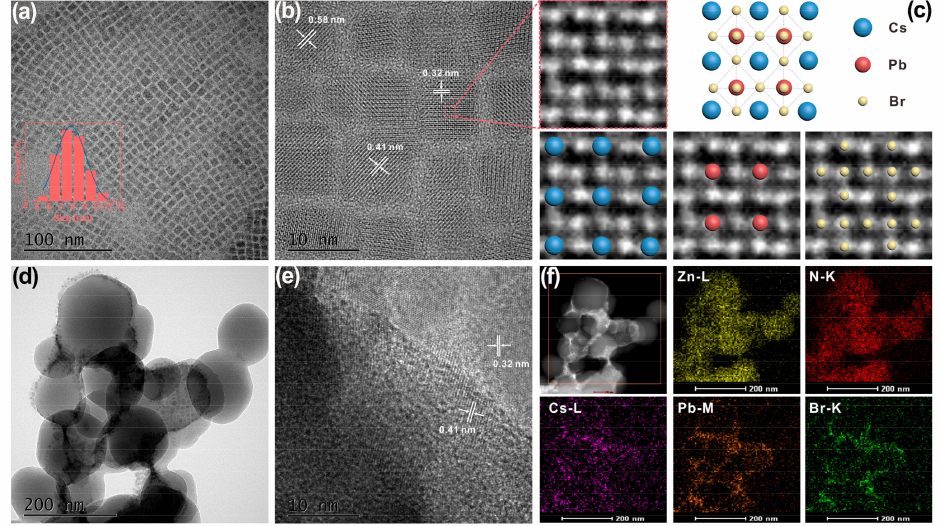
Figure 2. ( a ) TEM (inset: Size distribution) and ( b ) high-resolution TEM (HRTEM) images of monodisperse CsPbBr 3 quantum dots (QDs). ( c ) Enlarged HRTEM images of CsPbBr 3 QDs and the corresponding cubic crystal structure. ( d ) TEM and ( e ) HRTEM images of the CsPbBr 3 / ZIF-8 composite. ( f ) EDS elemental mapping images for Zn, N, Cs, Pb, and Br of CsPbBr 3 / ZIF-8